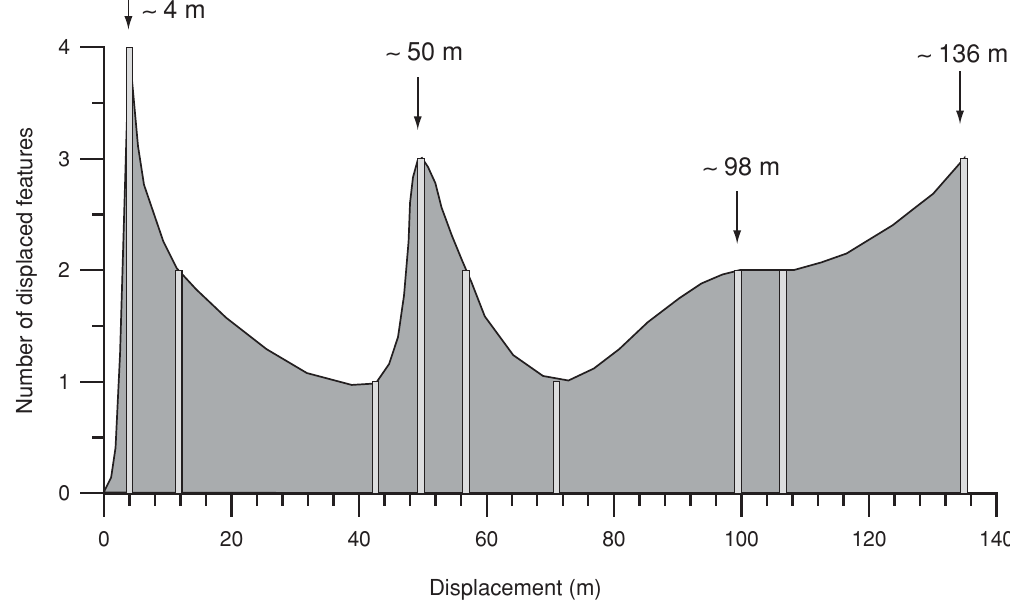
Fig. 8. Frequency histogram of lateral offsets (represented as Gaussian probability density functions) over 2.5 km distance along northwestern section of the North Tabriz Fault. Several peaks indicate the cumulative slip of offset channels could be associated with individual increments of 3.5-4.5